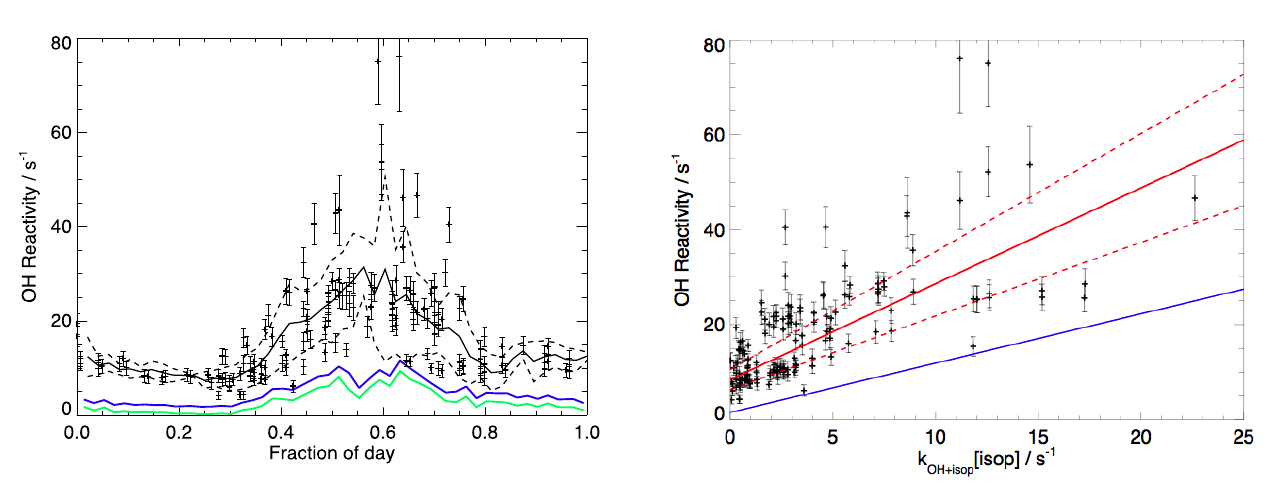
Figure 5: OH reactivity observations (black points with error bars indicating measurement uncertainties) plotted as a function of the calculated OH reactivity from isoprene alone for each measurement point. The solid red line is the linear least squares fit to the data, yielding a slope of 2.0 +/- 0.2, with the dashed red lines showing the 1 sigma uncertainty on the fit. The blue line is the fit to the calculated OH reactivities based only on the measured OH sinks (blue line in Fig. 3), with a slope of 1.1 +/- 0.01.